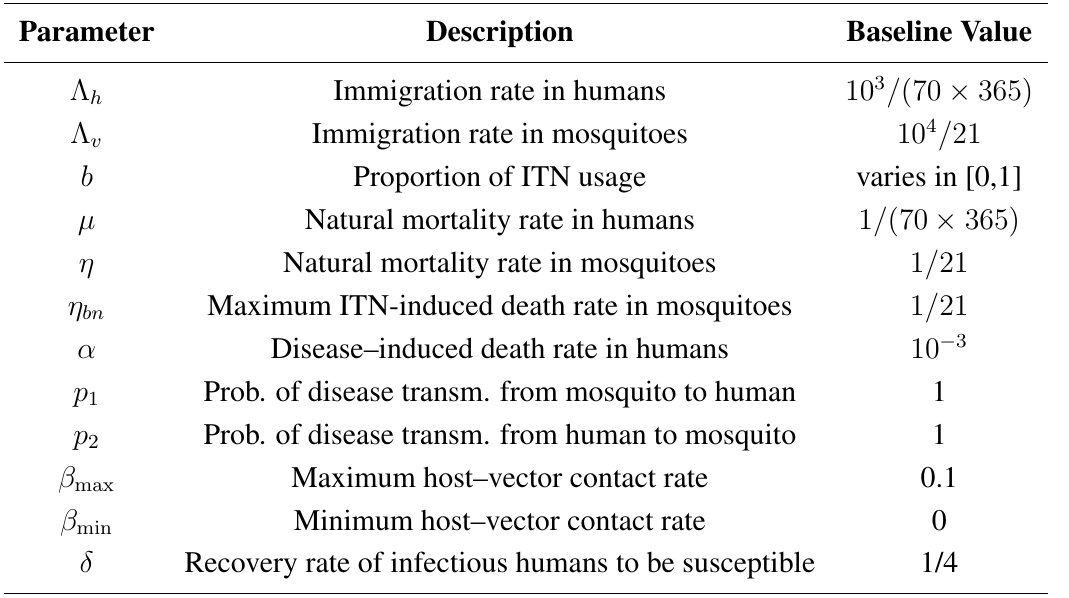
Table 1. Description of parameters in Model (1) and baseline values (taken from